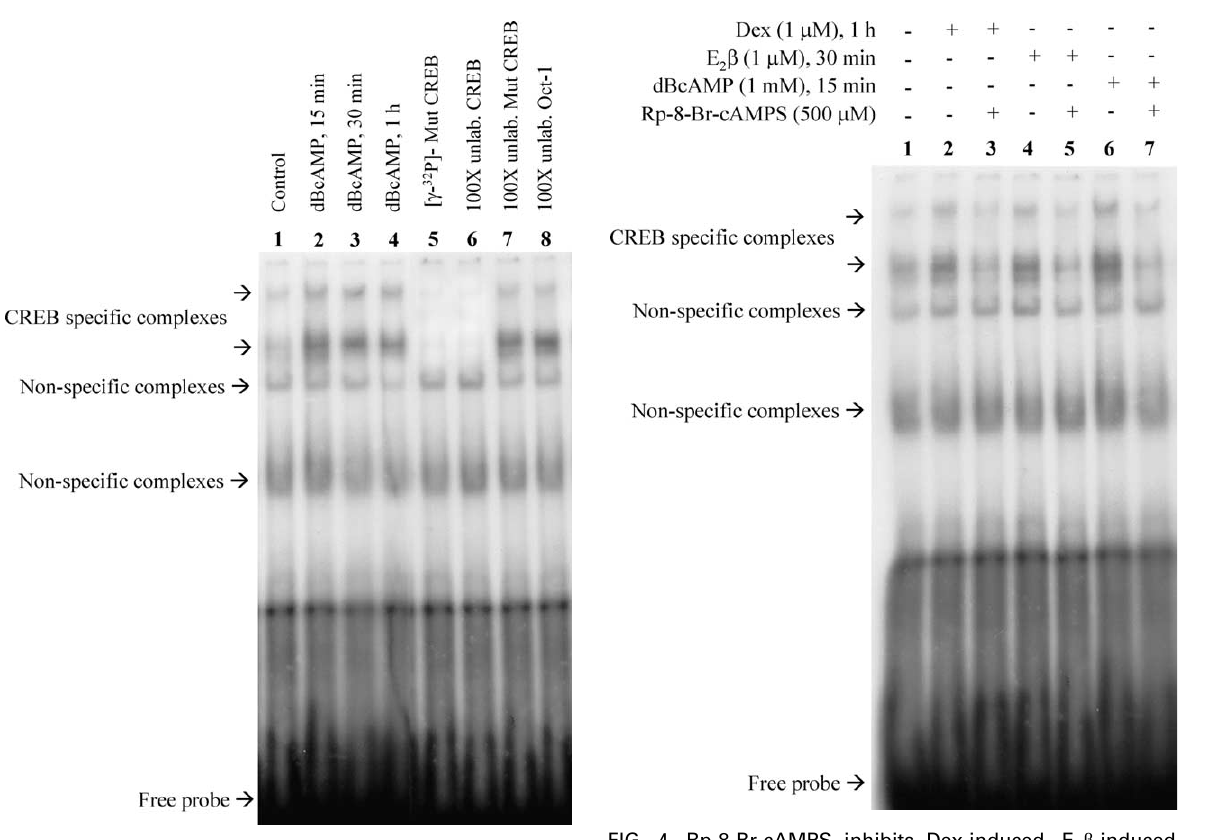
FIG. 3. dBcAMP induces CREB activation in CCRF-CEM cells. The cells were treated with dBcAMP (1 mM) (lanes 2 (cid:1) / 4), for 15 min, 30 min or 1 h, or left untreated (control, lane 1). Nuclear extracts were subjected to EMSA analysis as described in Materials and methods. Competition experi- ments with a 100-fold excess of unlabelled competitor probe relatively to the labelled CREB probe were performed using the nuclear extracts from cells treated with dBcAMP, for 15 min (lanes 6 (cid:1) / 8). EMSA analysis was also performed using a labelled mutant CREB probe (lane 5). The results shown are representative of three independent experiments.